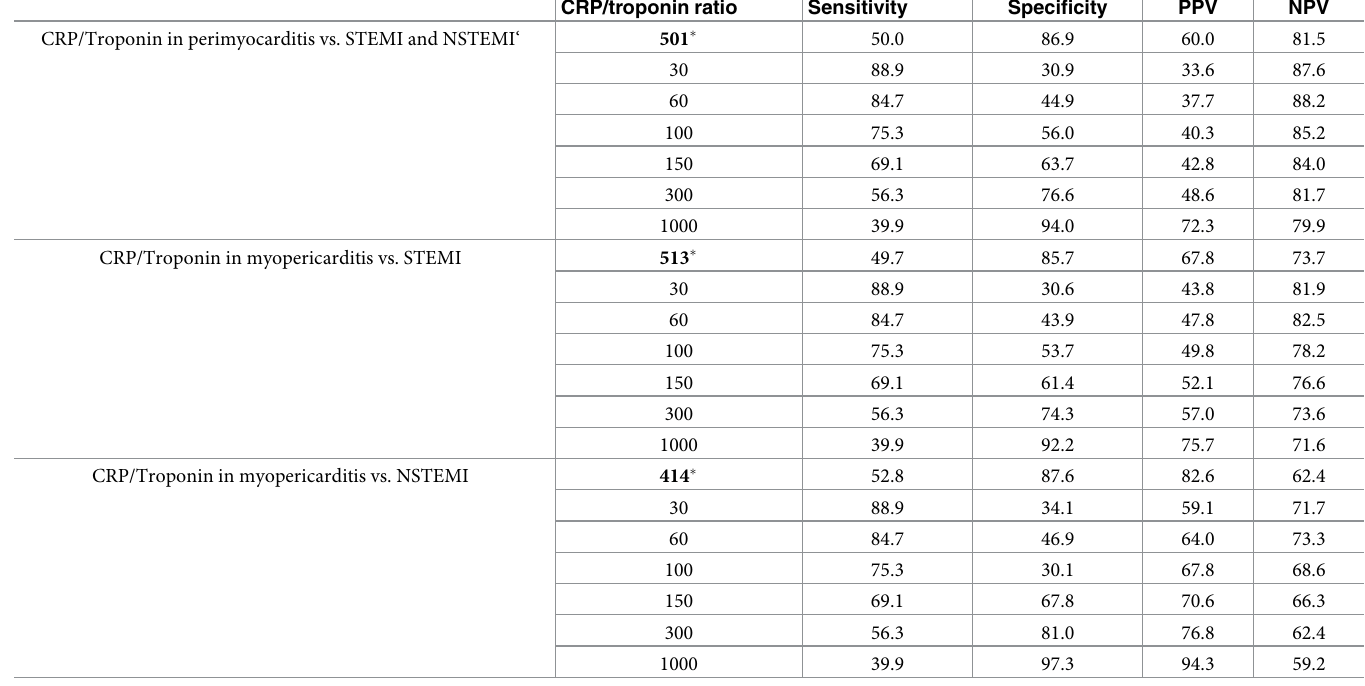
Asterisks denote Youden